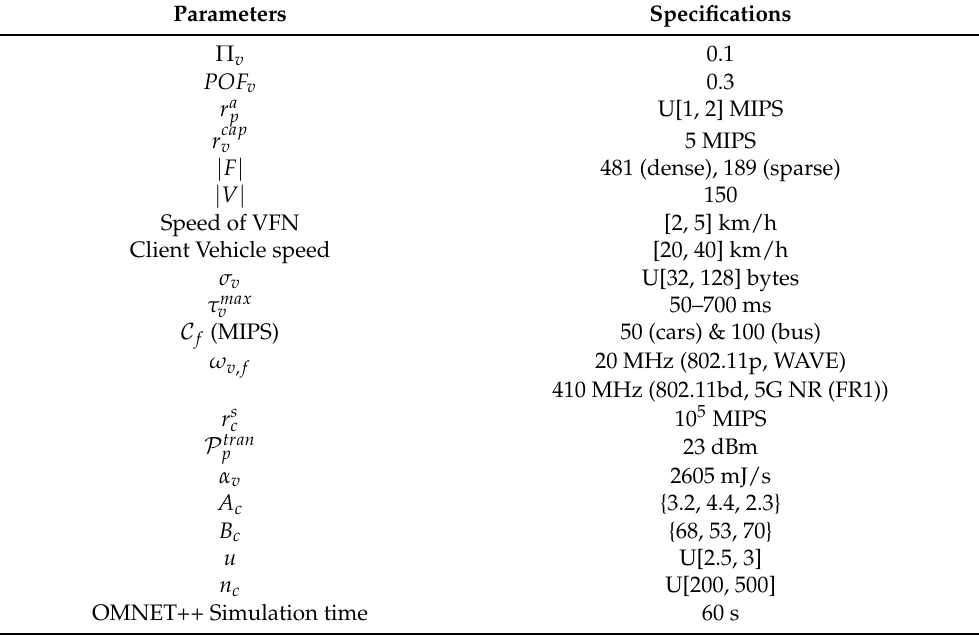
Table 4. Network specification and simulation parameters. Parameters